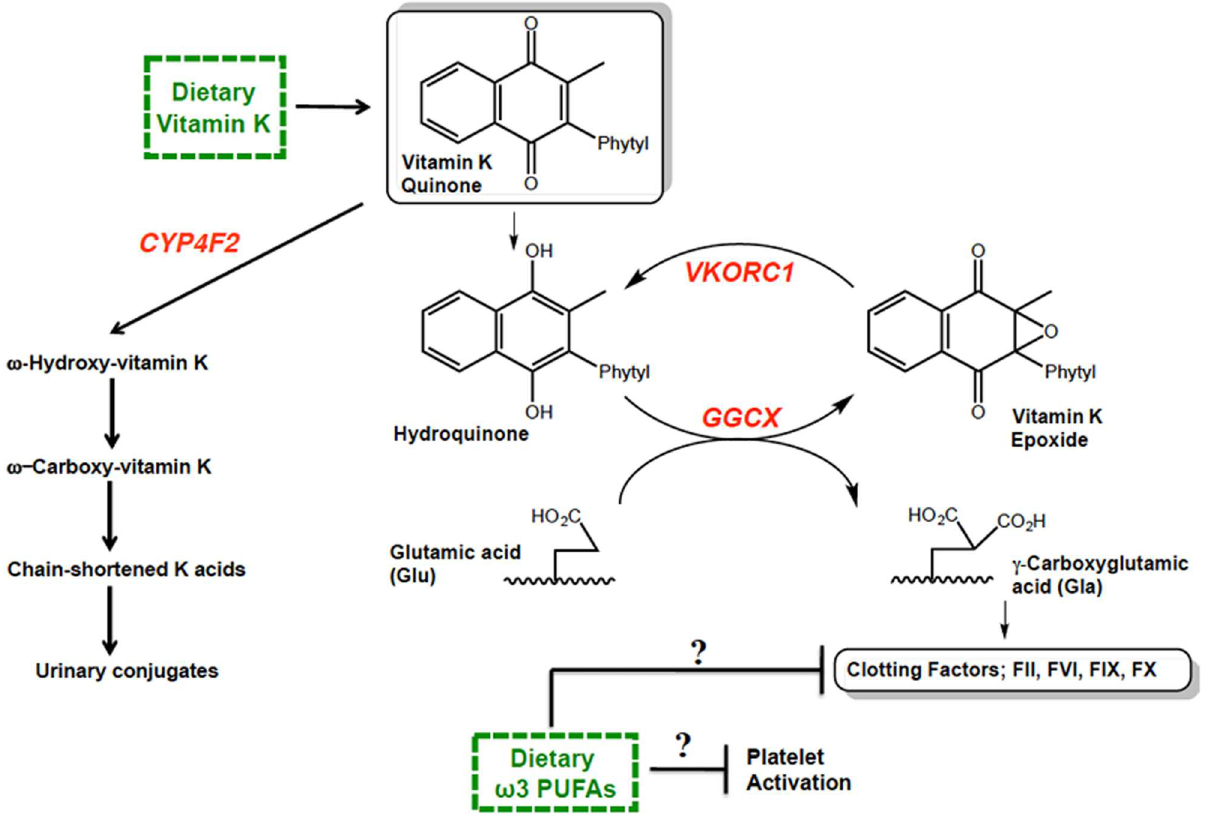
Fig 1. Scheme illustrating potential vitamin K cycle gene-diet interplay in modifying hemostasis. Vitamin K cycle-related genes highlightedin red are VKORC1 , GGCX , CYP4F2 . The dietary factors investigated; vitamin K and ω 3polyunsaturated fatty acids ( ω 3 PUFAs), are boxed in